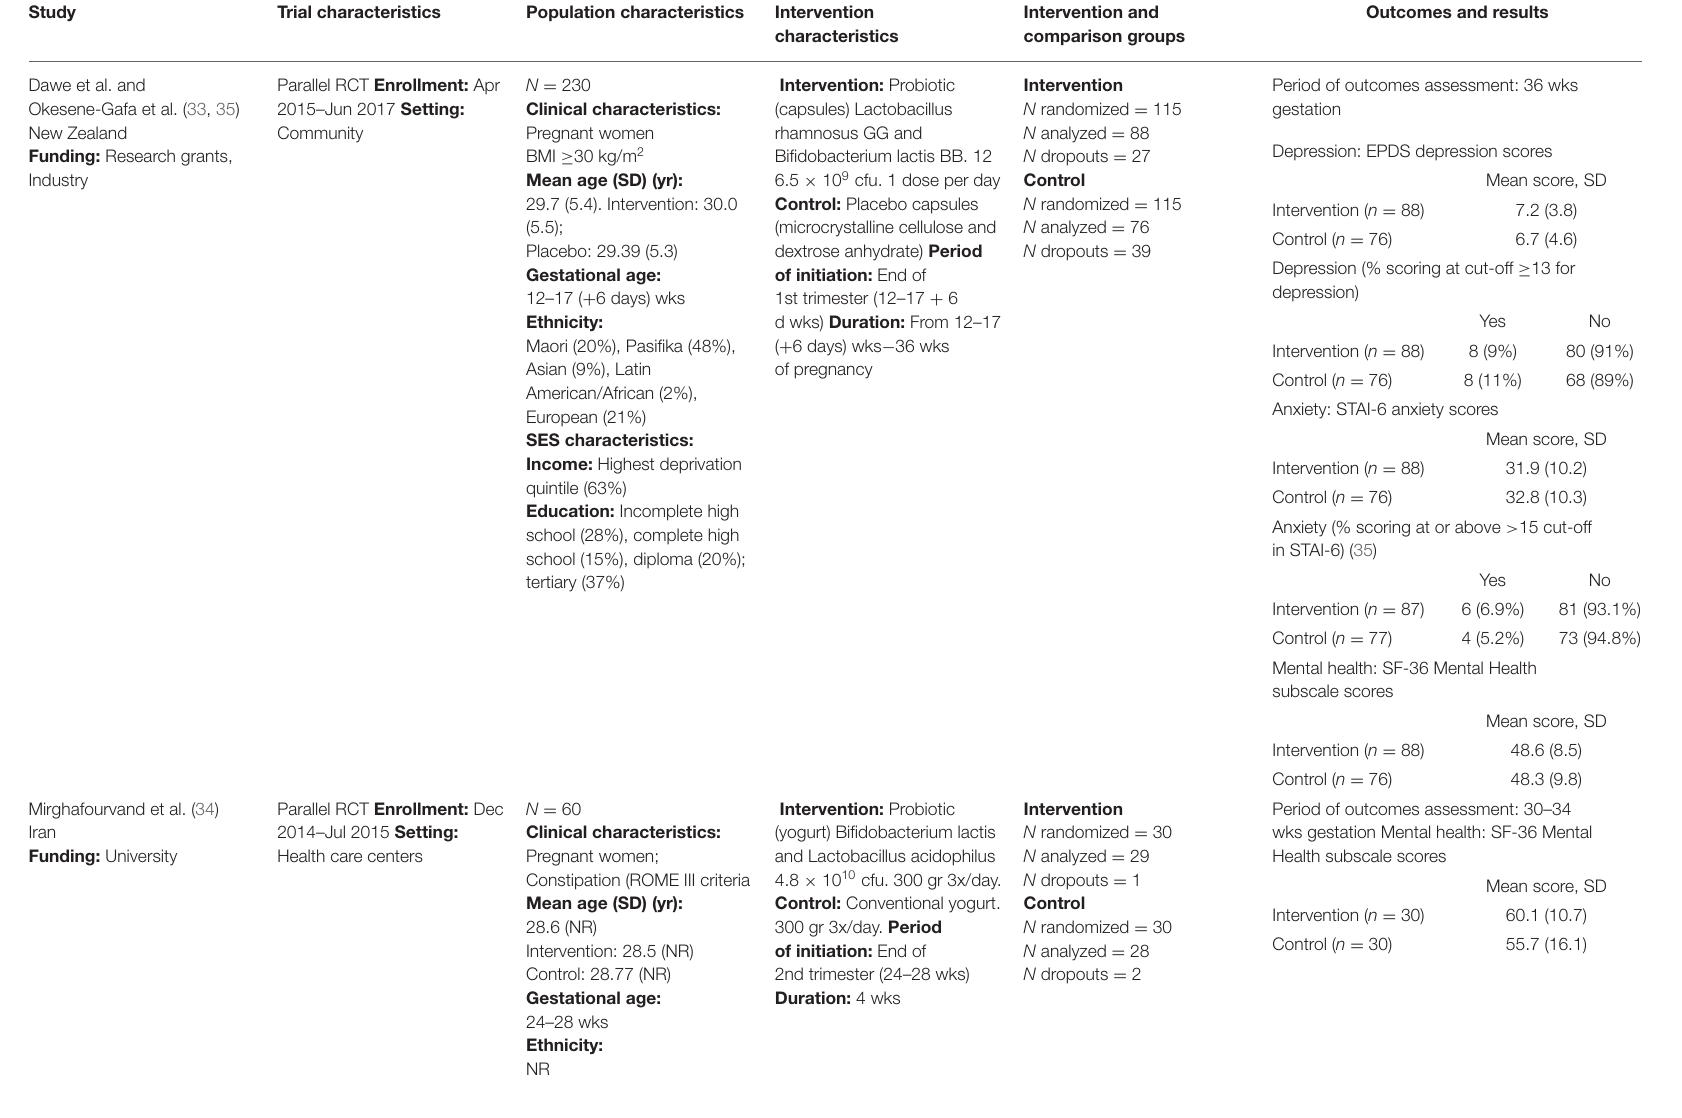
TABLE 1 | Characteristics of the included